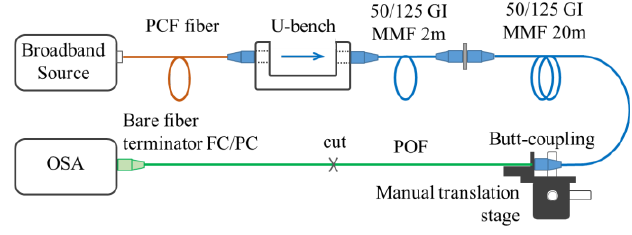
Fig. 2. Schematic of the experimental setup.